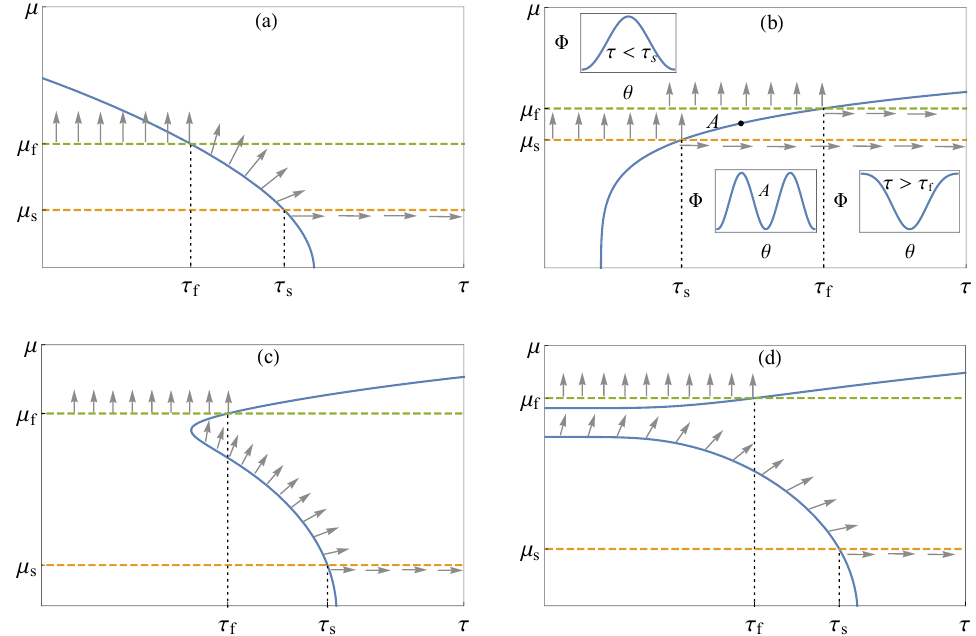
Figure 2. Illustrations of typical ( a , b ) and unconventional ( c , d ) SR transitions predicted by simple (quasi)doublet model (see text for detail). The arrows indicate the direction of the antiferromagnetic vector G in the ac plane. The insets in panel ( b ) show the θ -dependence of the free energy. Figure 2c, built with K 1 = 1, γ = − 0.222, ∆ a = 6.72, ∆ c = 1.63, which